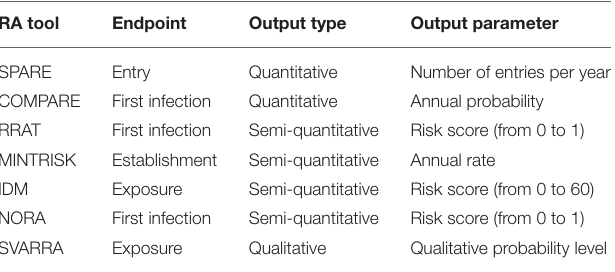
TABLE 3 | Risk of ASF incursion as evaluated by the seven generic RA tools. RA tool